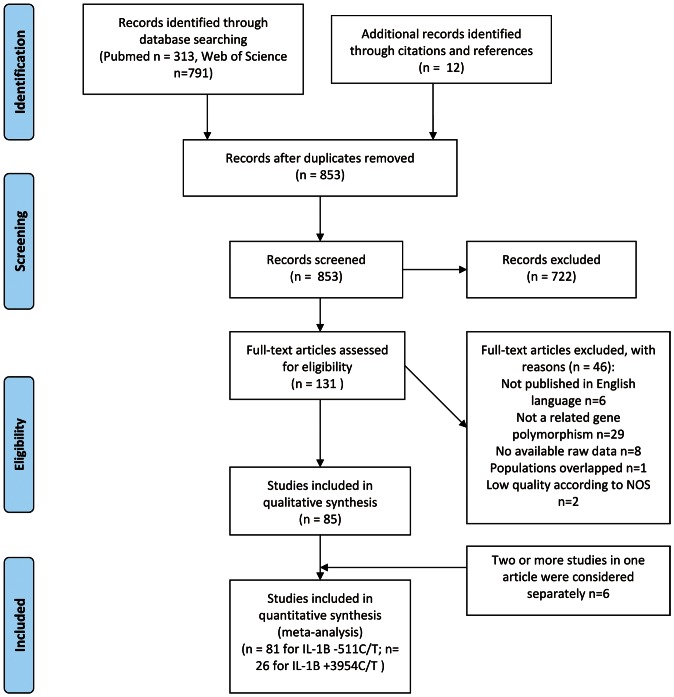
Flow chart of study selection.